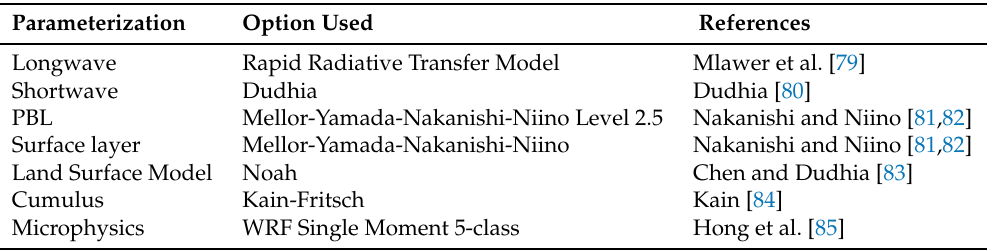
Table 2. Weather Research and Forecasting (WRF) model physics parameterization